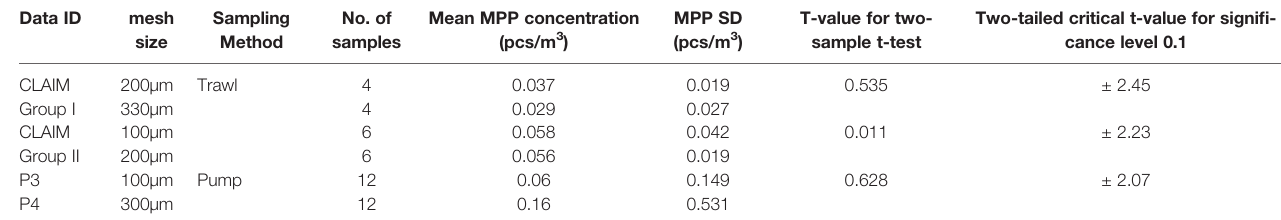
TABLE 3 | Inter-comparison of microplastic datasets using nets with different mesh sizes. Data